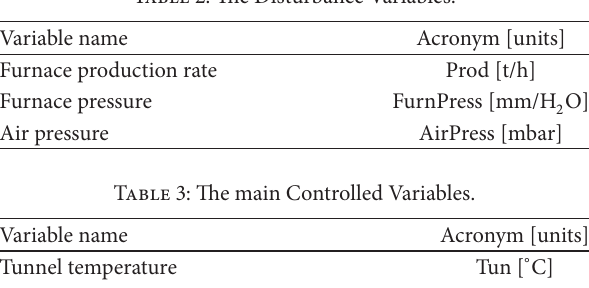
Table 2: The Disturbance Variables.